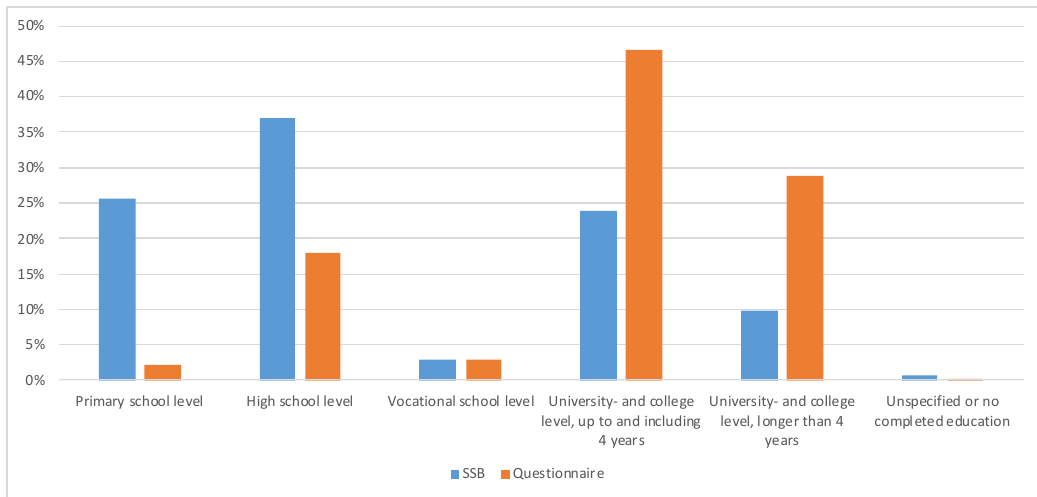
Figure 2. Comparison of municipality distributions, in %, the population based on data from Statistics Norway (SSB) vs. the questionnaire N = 305.